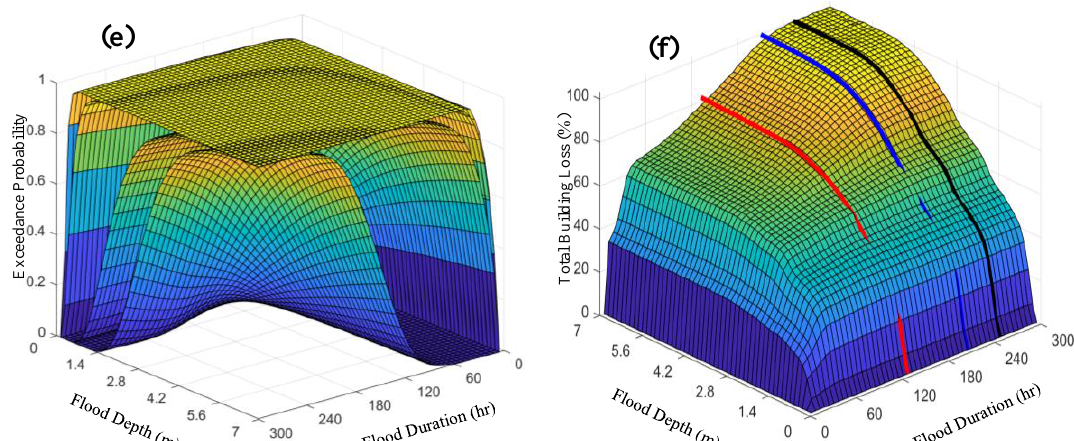
Figure A16. F2 archetype analysis results: ( a ) Component fragility curves; ( b ) Building fragility curves; ( c ) Selected components’ loss curves; ( d ) Building loss curves; ( e ) Building fragility surfaces; ( f ) Building loss surface.